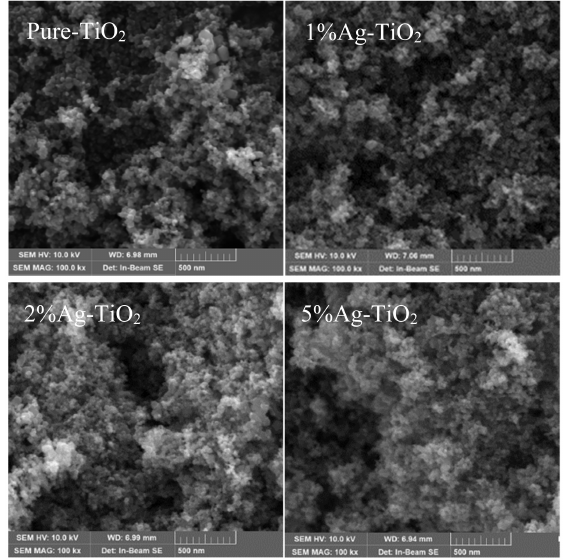
Figure 3. SEM images of Ag-TiO 2